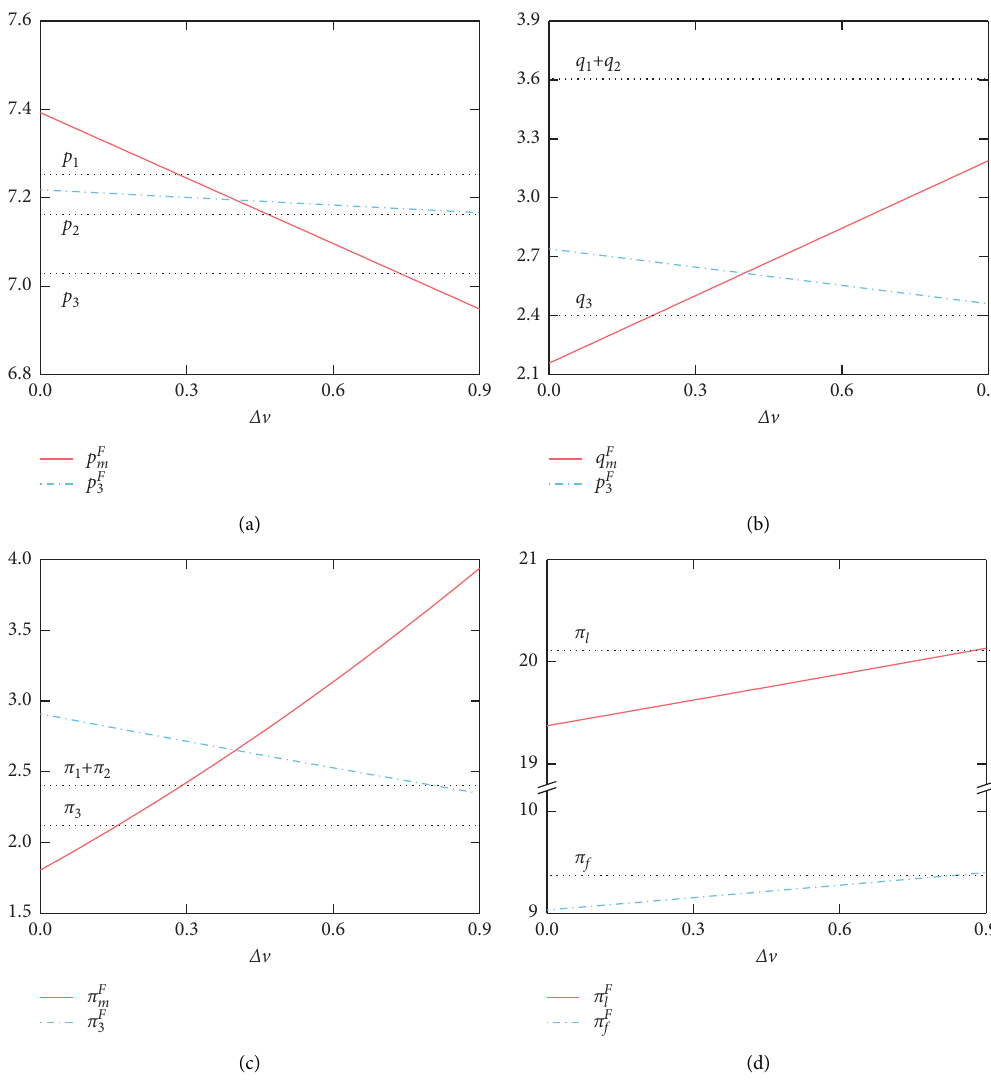
Figure 1: Effect of Δ v on equilibrium results of supply chain when β � 0 .